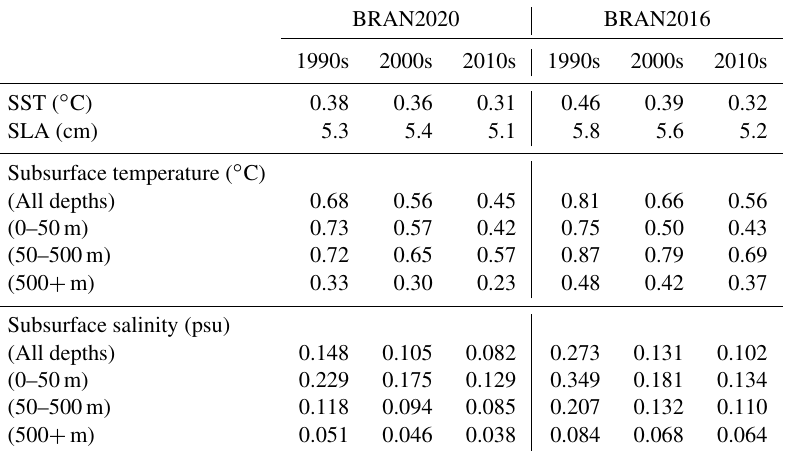
Table 3. Decadal averages of mean absolute values of background innovations for BRAN2020 and BRAN2016. These statistics provide an indication of how well the model integrates BRAN analyses forwards in